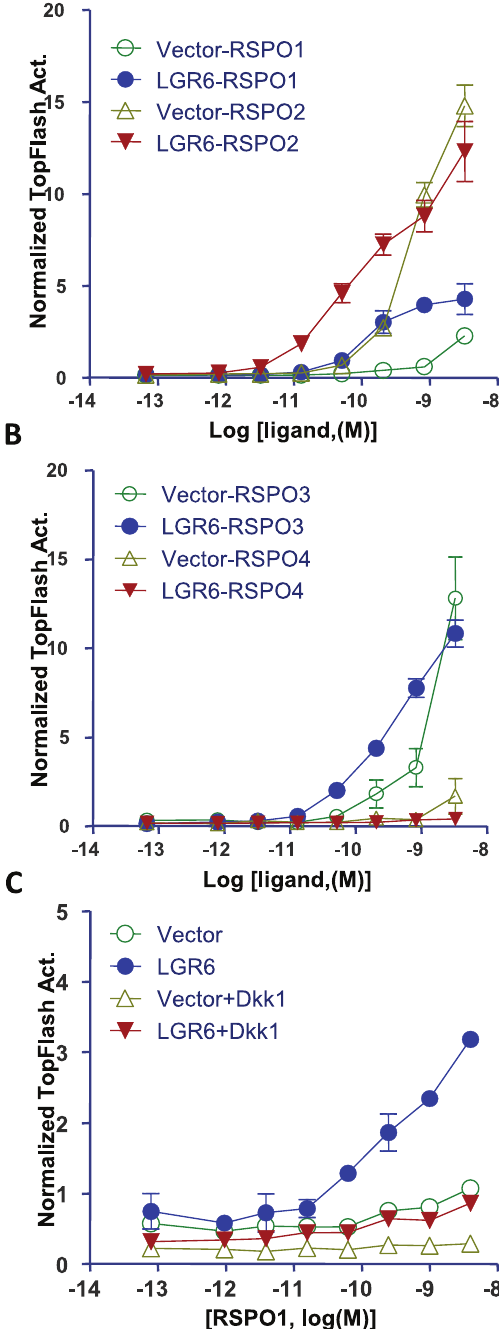
Figure 2. LGR6 enhances Wnt/ b -catenin signaling in response to RSPO1–3 and this activity is inhibited by Dkk1. HEK293T cells were transiently transfected with LGR6 or vector control, plus Dkk1 expression plasmids as indicated, along with the b -catenin reporter plasmid super 8 6 TOPFlash (firefly luciferase) and pRL-SV40 (renilla luciferase) and then stimulated with serial dilutions of purified recombinant RSPO1–2 (A), RSPO3–4 (B) or RSPO1 (C) in the presence of Wnt3a CM. Firefly luciferase activity of each well was normalized to that of renilla luciferase activity of the same well. All error bars are SEM (n=4).